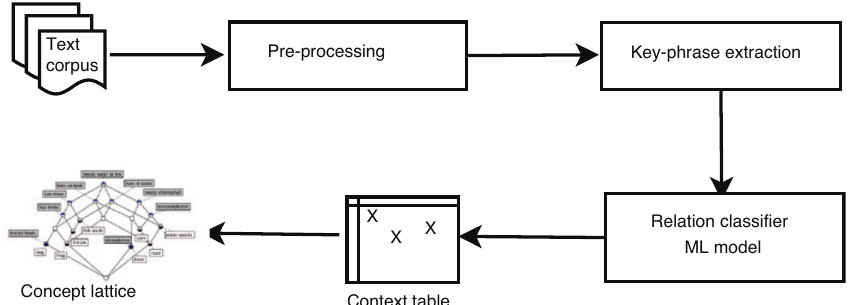
Figure 3: Overall Workflow of the Proposed